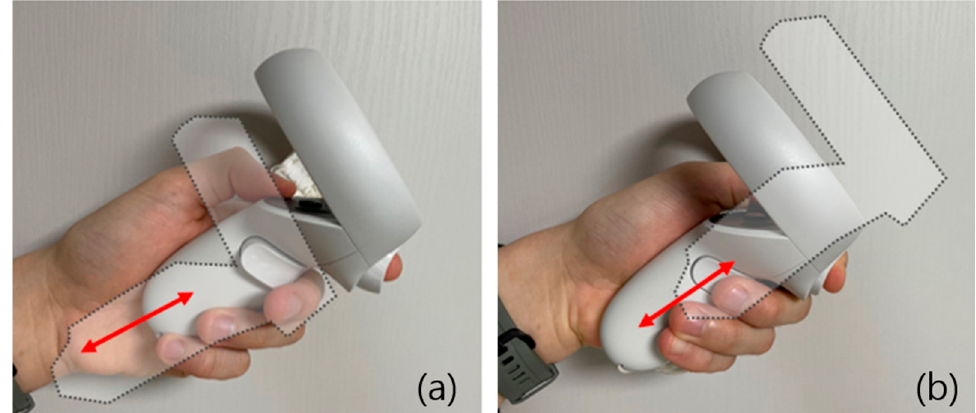
Figure 1. Force of pushing in or pulling out of the tool in the hand to simulate wielding a tool or interacting with an object. ( a ) Feeling of the tool being pushed into the hand when interacting with a VR object; ( b ) feeling of the tool being pulled out of the hand when swinging or interacting with a VR object.